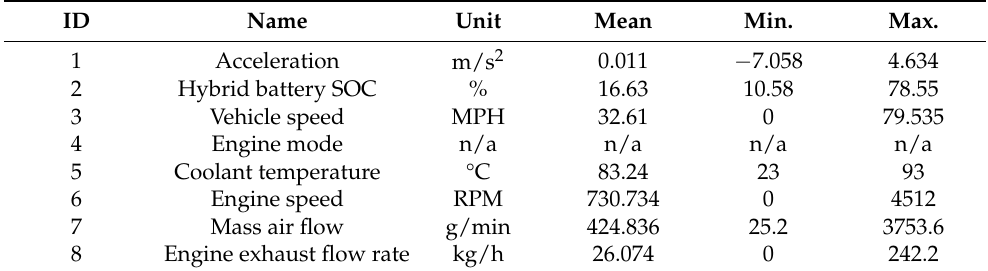
Table 2. Statistical values for each of the input features selected in the final